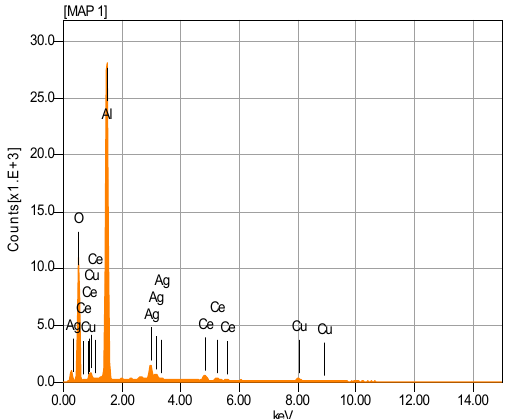
Figure 5. EDS spectrogram of AgCuAlCe bimetallic-supported catalyst. and Ce, indicating that Ag and Cu NPs were effectively deposited on the AlCe surface in a 350 μ m 2 area.